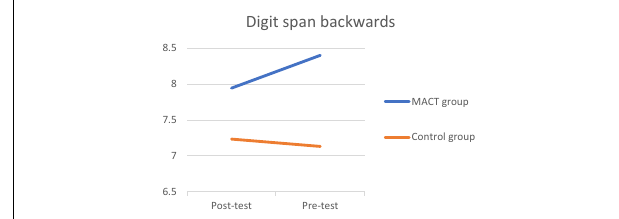
FIGURE 3 | Digit span backward.